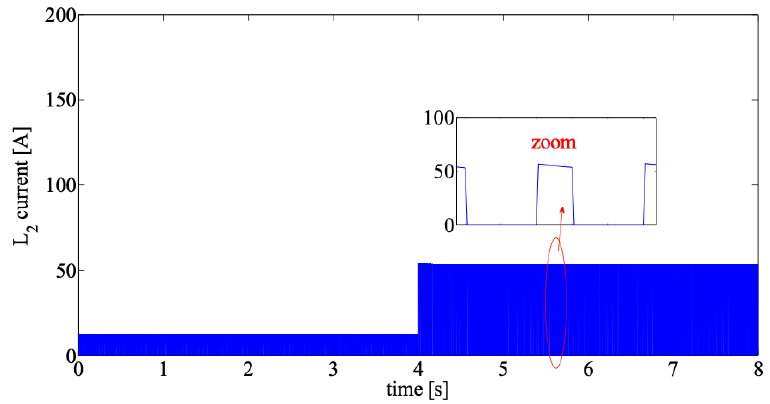
Figure 13. Current in inductor L 2 (case A).